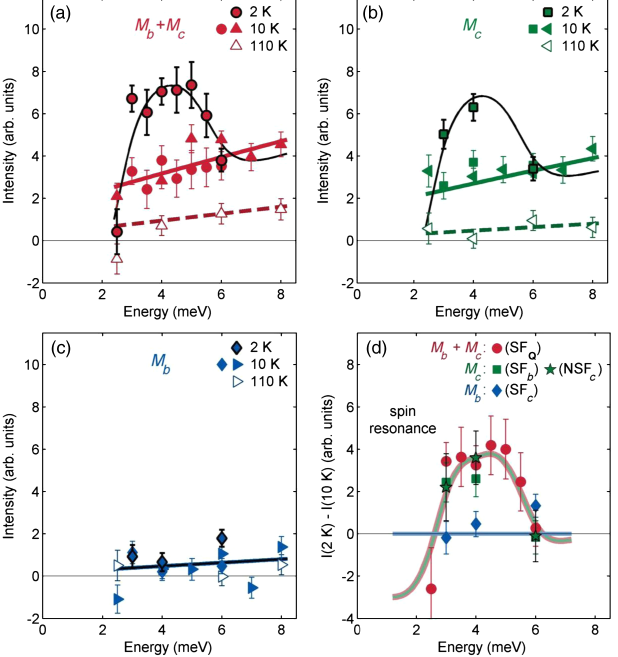
FIG. 3. Evolution of different spin-fluctuation components with b þ temperature. (a) – (c) Net magnetic signal components at Q ¼ ð 1 ; 0 ; 0 Þ at three different temperatures, obtained by subtracting the globally determined BG intensity (see Fig. 2 and Supple- mental Material [21]) from SF Q , SF , and SF data, respectively. b c measured in different geometries. (d) Intensity change across T c The non-spin-flip scattering geometry with incoming neutron spin polarization along c (NSF ) measures spin fluctuations along c the c direction and confirms the spin-flip (SF ) result. Solid b lines are guides to the eye. The two sets of symbols in (a) – (c) for 10 K represent data obtained with different sample-environment devices (see Supplemental Material